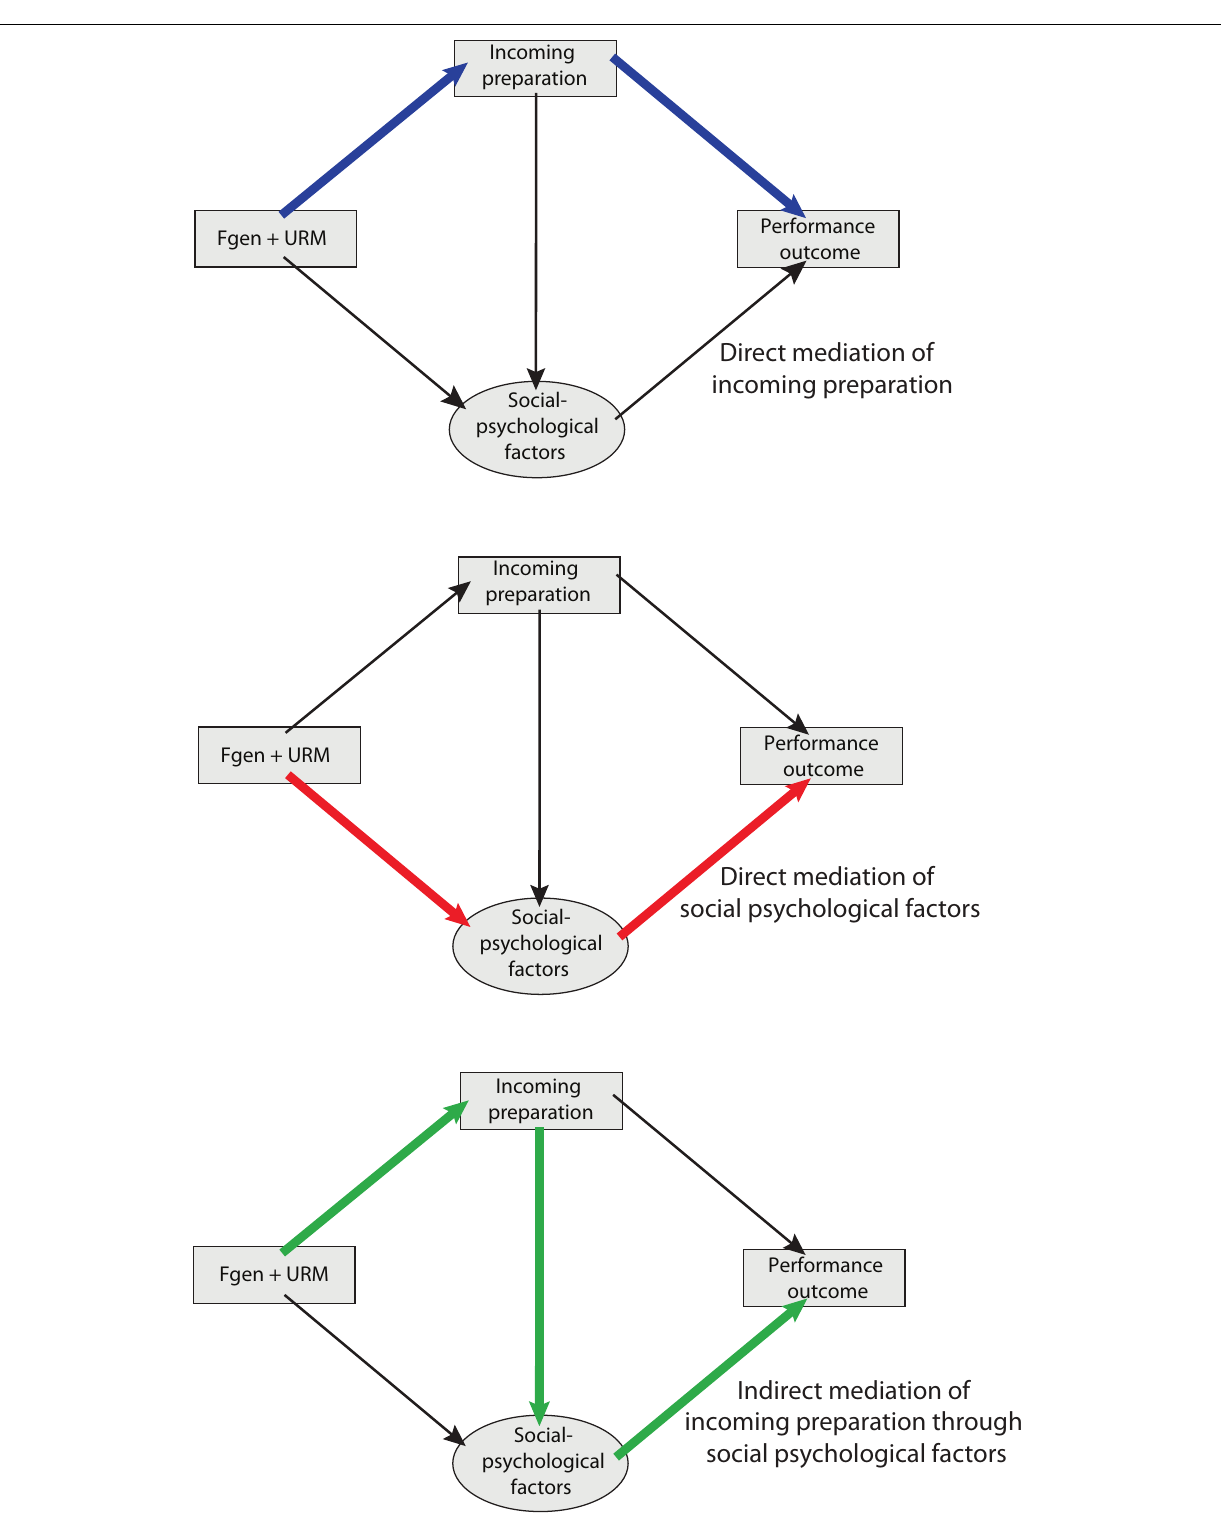
Frontiers in Education |